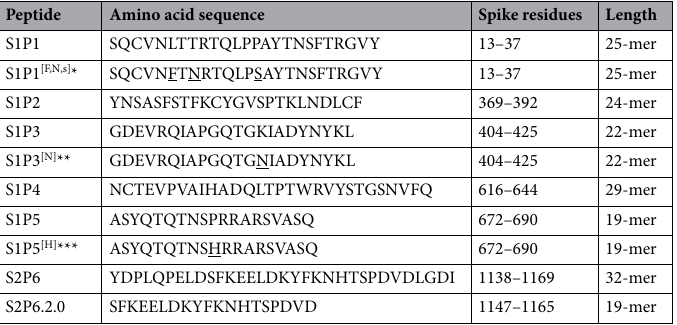
Table 1. Sequences of synthetic peptides and their variants. *Gamma, **Beta/Omicron, and ***Alpha variants of SARS-CoV-2 according to WHO label. The amino-acid substitutions are